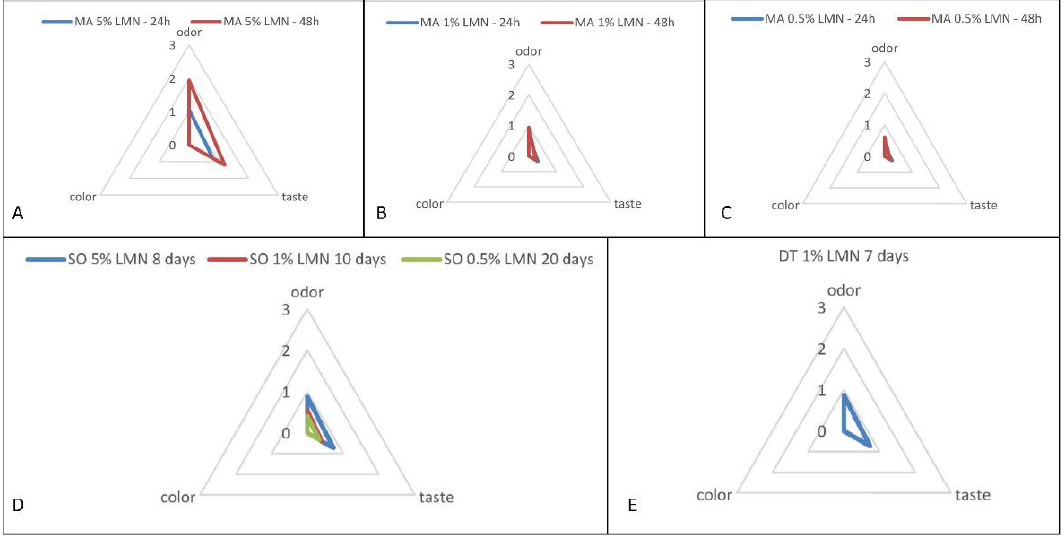
Figure 6. Sensory analysis (odor, color, and taste) of anchovy fillets treated with several R (+) limonene (LMN) concentrations in three different treatments: ( A ) 5% of LMN in marinating solution a 4 °C (MA-Treatment 1); ( B ) 1% of LMN in marinating solution a 4 °C (MA-Treatment 1); ( C ) 0.5% of LMN in marinating solution a 4 °C (MA-Treatment 1); ( D ) 5%, 1%, and 0.5% of LMN in sunflower seed oil (SO-Treatment 2); ( E ) 1% of LMN a double treatment both during marinating process as and subsequent storage in sunflower seed oil (DT-Treatment 3). This survey was carried out by a panel of fifteen untrained, random people of both genders.